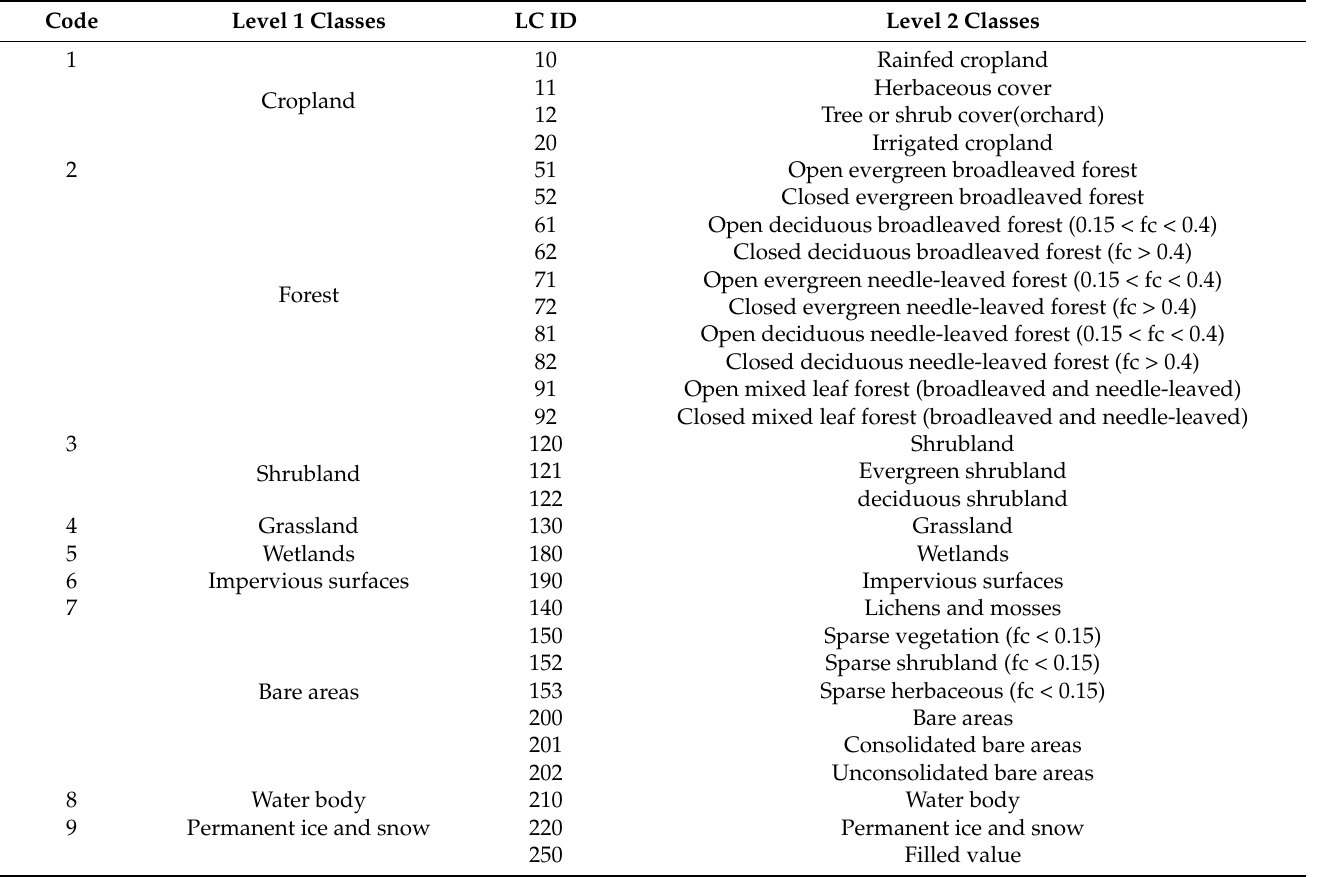
Table 1. Land use/land cover classification system of